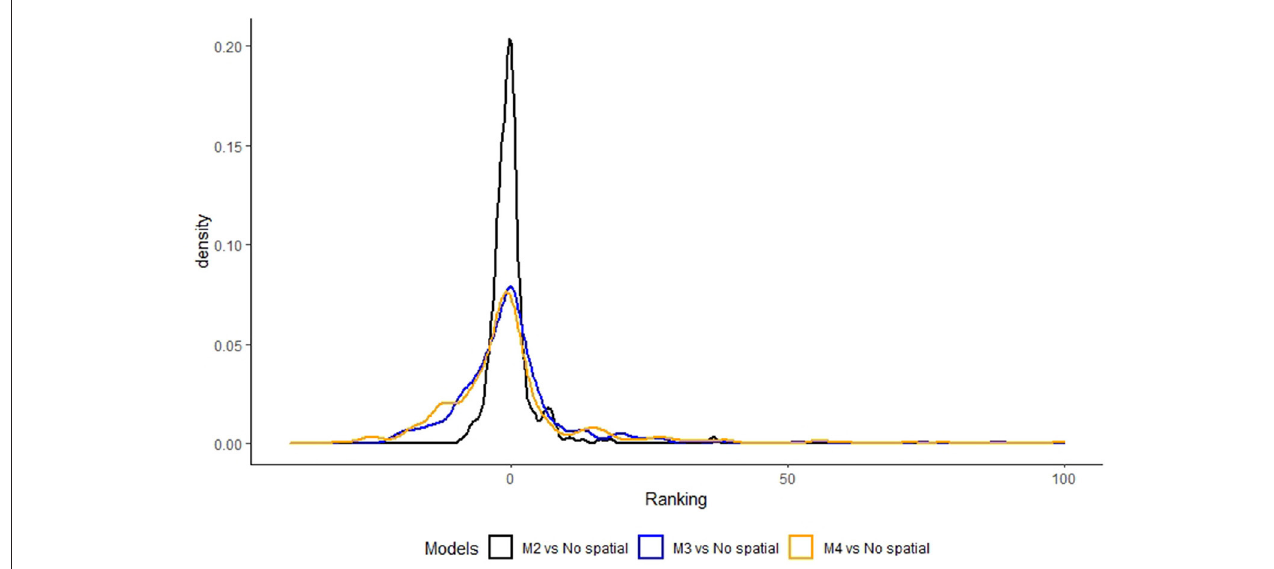
FIGURE 12 | Technical efficiency ranking differences of models 2–4 compared to Model 1 for irrigated